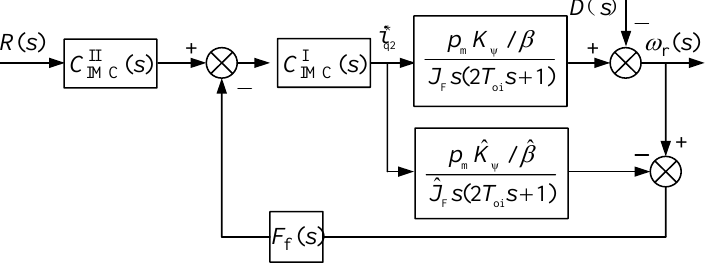
Figure 13. Dynamic structure of the speed loop based on the 3-DOF-IMC. * means the reference value. (1) The controlled object: G ( s )